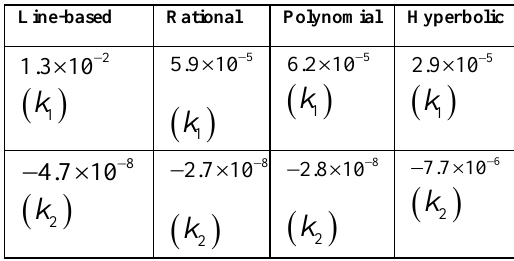
Table 1: Distortion coefficients' estimates